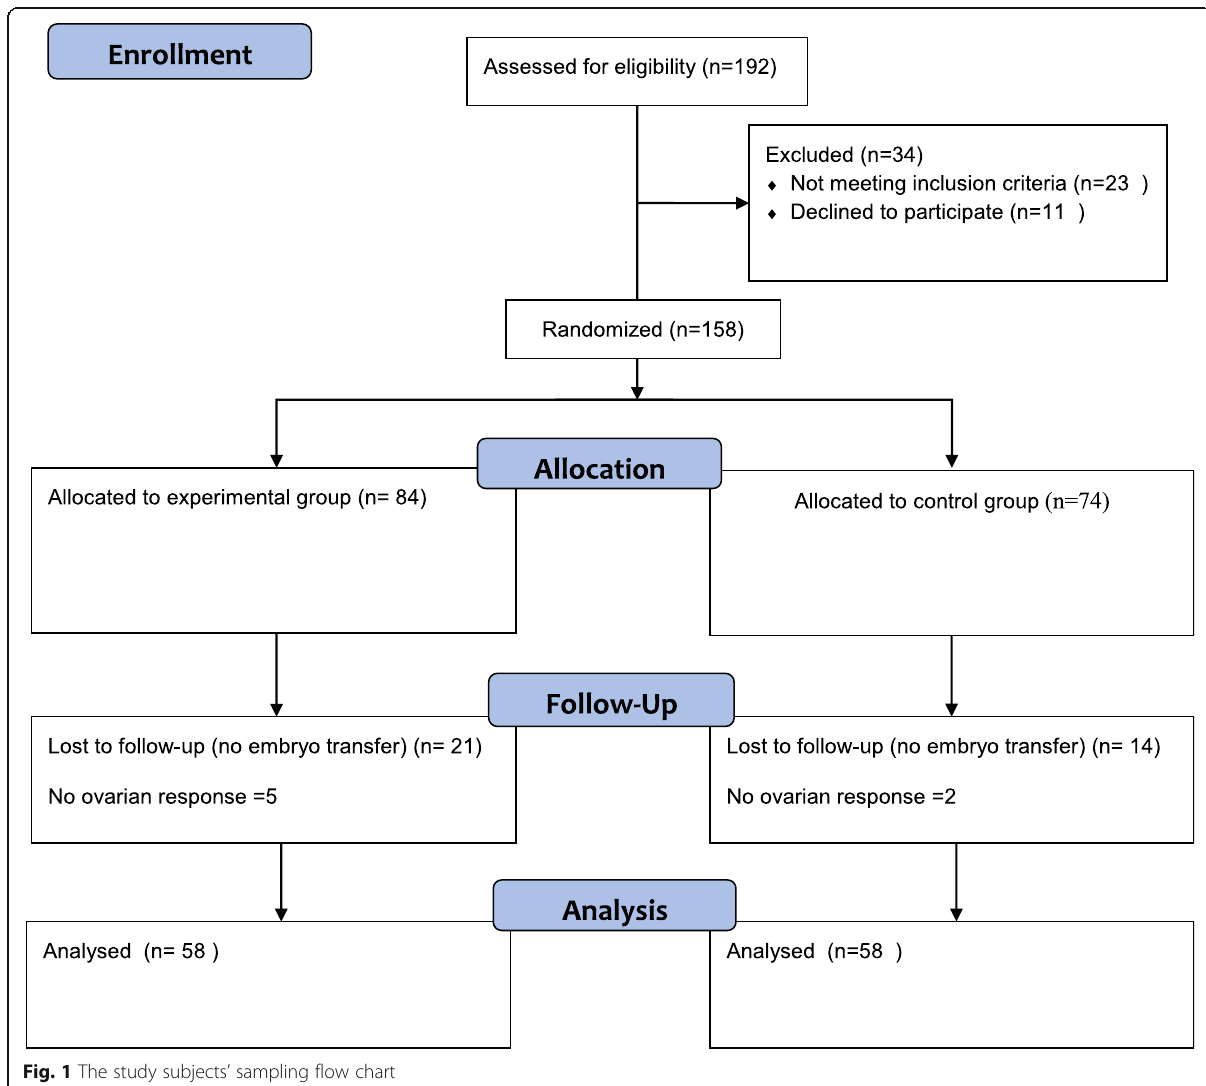
Fig. 1 The study subjects ’ sampling flow chart